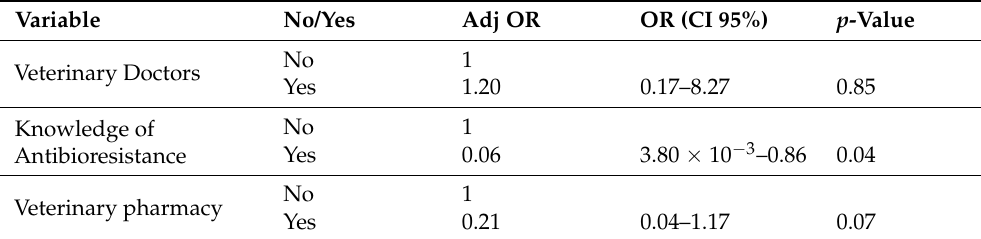
Table 5. Distribution of associated factors using multivariate logistic regression